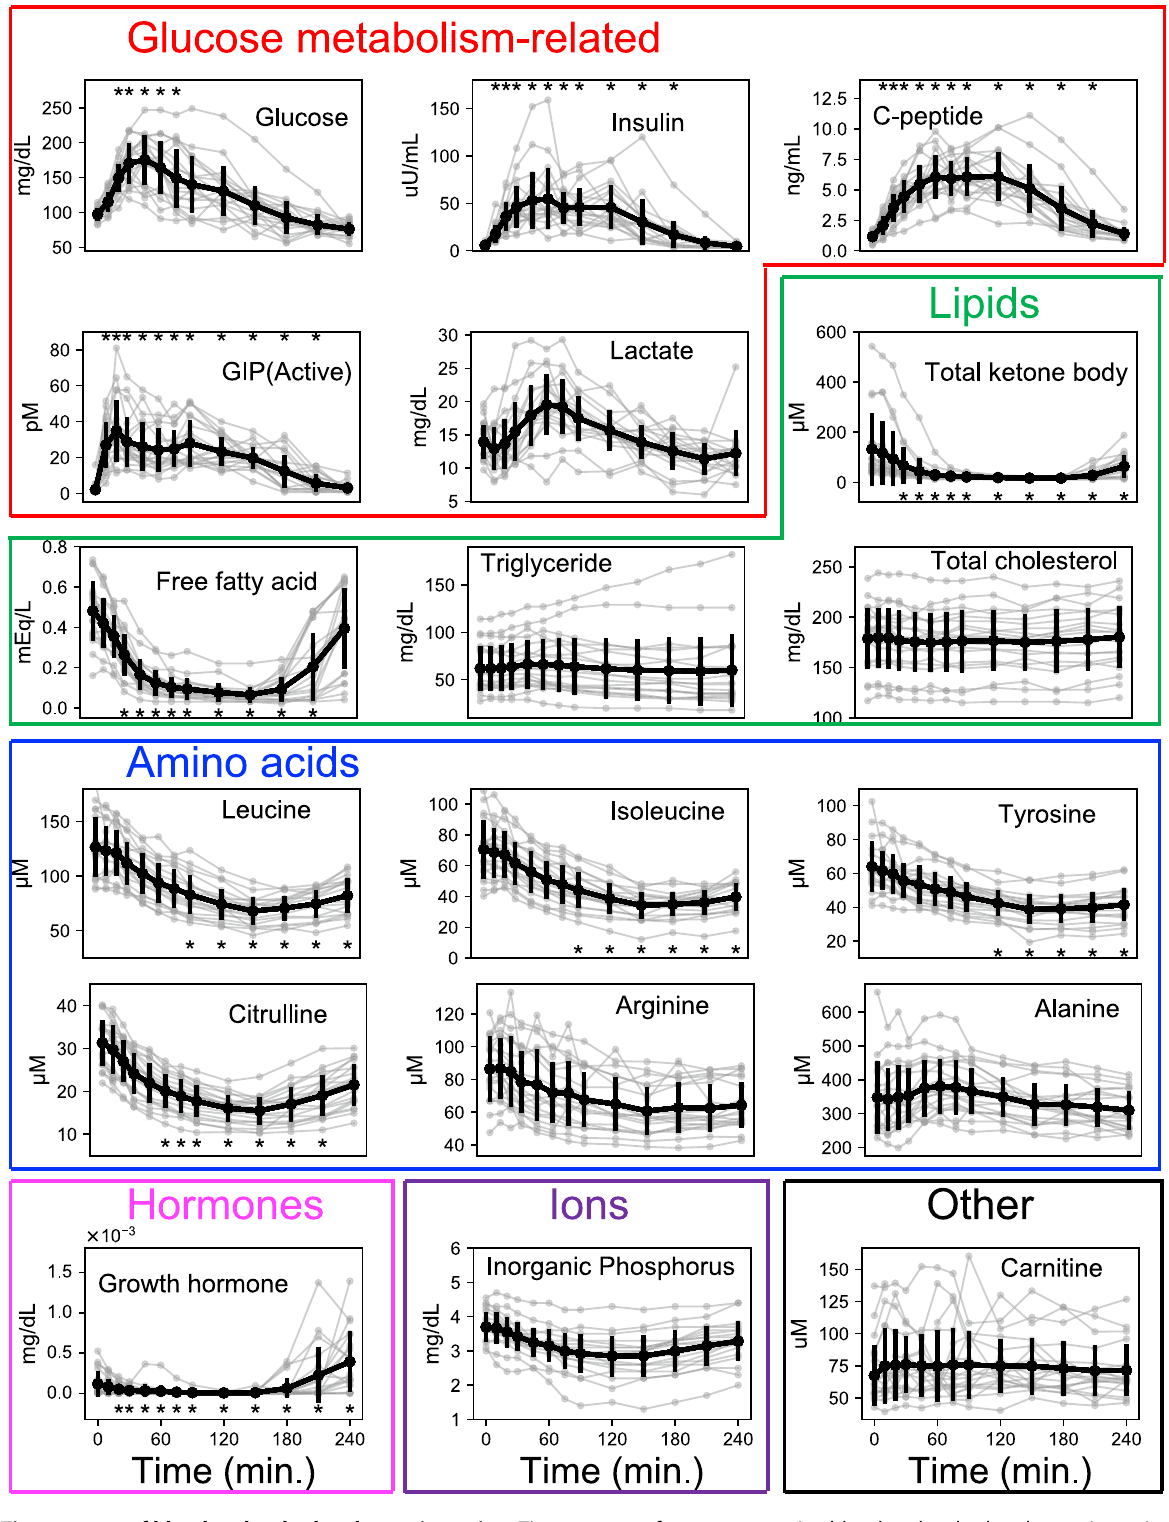
Fig. 1 Time courses of blood molecules by glucose ingestion. Time courses of 18 representative blood molecules by glucose ingestion in 20 healthy human subjects. Gray, each subject; black, the mean with a standard deviation of 20 subjects. Red box, glucose metabolism-related molecules; green box, lipids; blue box, amino acids; pink box, hormones; purple box, ions; black box, other metabolites. The asterisks indicate the time points (in minutes, min.) when molecules showed an absolute log2 fold change to the value at fasted state larger than 0.585 (2 0.585 = 1.5) and a false discovery rate- (FDR-)adjusted p -value ( q -value) <0.1 (Supplementary Fig. 3). Abbreviations for the molecule as follows:GIP (active), gastric inhibitory polypeptide